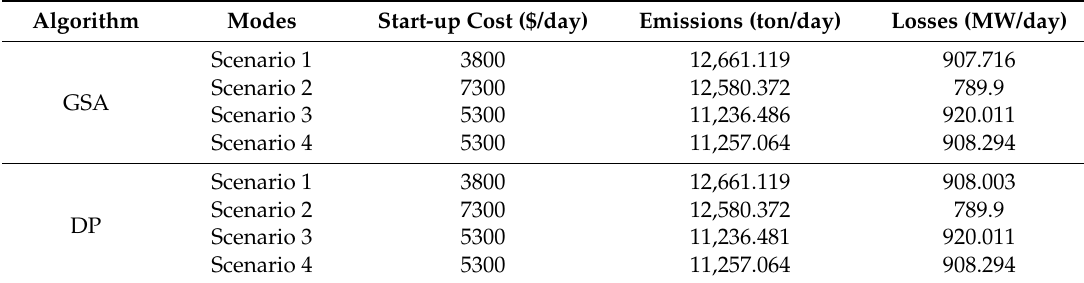
Table 7. Results synopsis for GSA and Dynamic Programming (DP) (implicating emission cost and losses of the